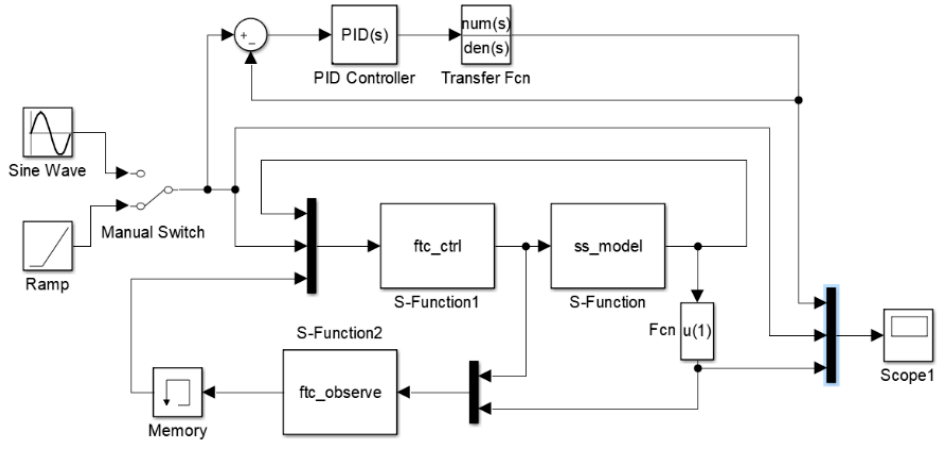
Figure 5. Simulation diagram of finite-time compound control for the continuous rotary motor.